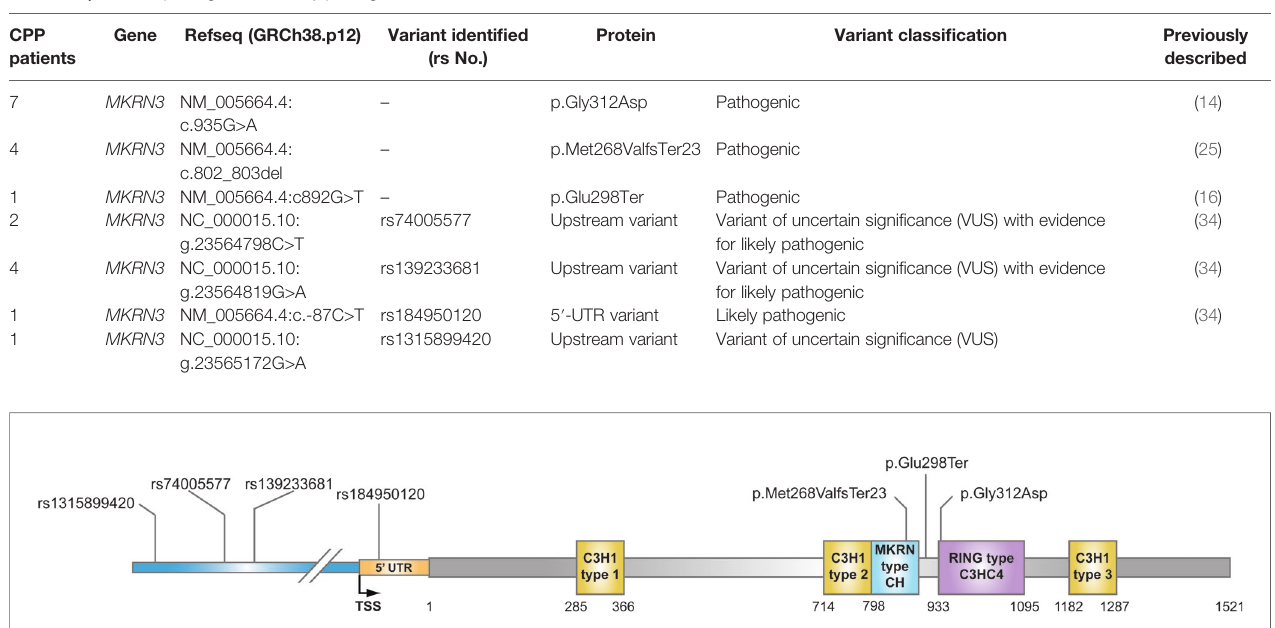
FIGURE 1 | Schematic representation of the MKRN3 gene with the mutations/variations identi fi ed in this study. The fi ve zinc- fi nger domains in the coding region of MKRN3 gene are indicated: three C3H1 motifs, one C3HC4 RING motif, and one MKRN-speci fi c Cys-His domain. MKRN3 domains are positioned in relation to start codon via nucleotide numbering of coding